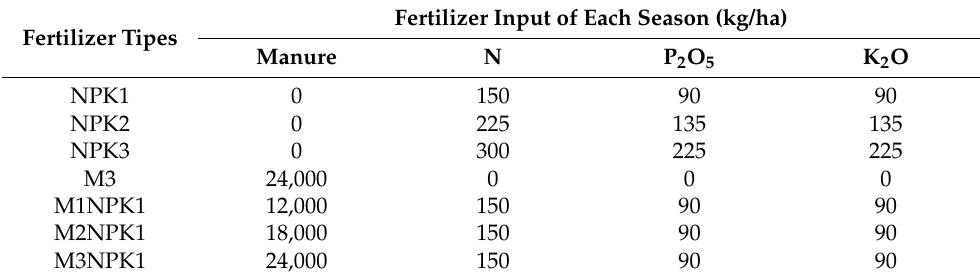
Table 6. Application levels of organic and inorganic fertilizers. Fertilizer